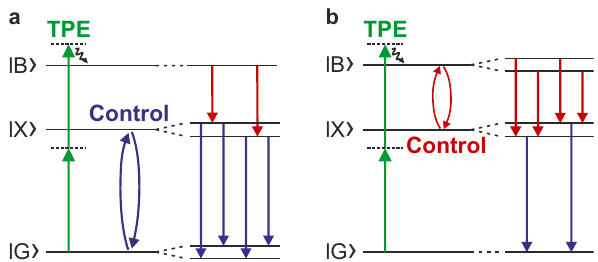
Fig. 4 Energy levels for resonant control laser. a The control laser drives the j X i – j B i -transition, creating dressed states and forming a Mollow triplet. The | B 〉 – | X 〉 -transition is split in two lines. b The control laser drives the | B 〉 – | X 〉 -transition, creating dressed states and a Mollow triplet. The| B 〉 – | X 〉 - transition is split in two